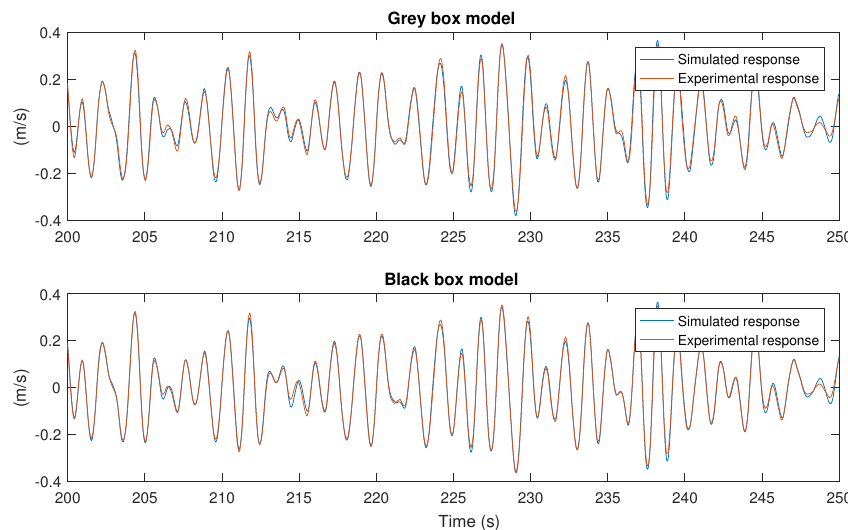
Figure 26. Time-domain responses of the both the black box model and the grey box model, compared to the experimental response. The identification has been carried out using experiment 091 and validation has been carried using data from experiment 085, where the linear equivalent damping has been adjusted according to